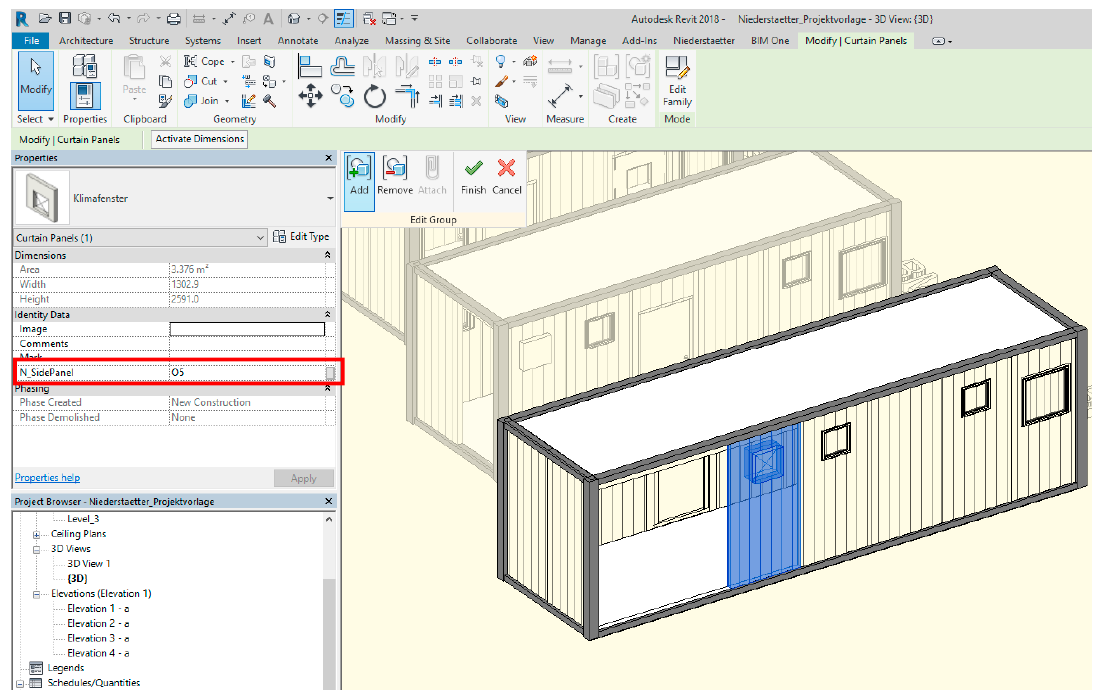
Figure 7. Building Information Modeling (BIM) object library in basic configuration.